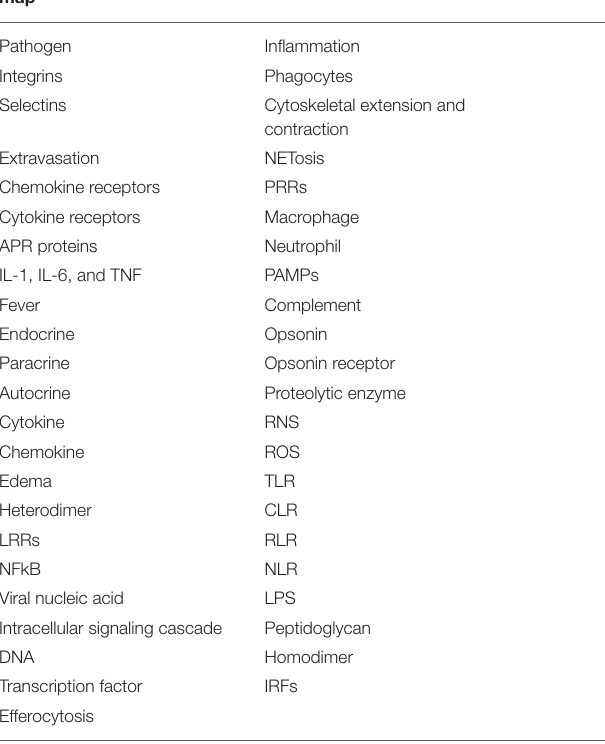
TABLE 4 | Terms for the concept map shown in Figure 2 . Terms to be used in your innate immunity and inflammation concept map